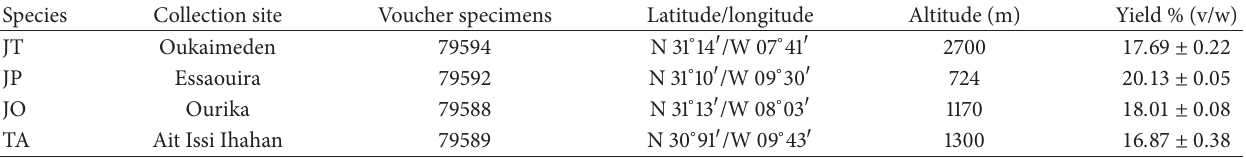
Table 1: Collection site and geographical coordinates of the species studied and percentage yields (%) of the water extract obtained.